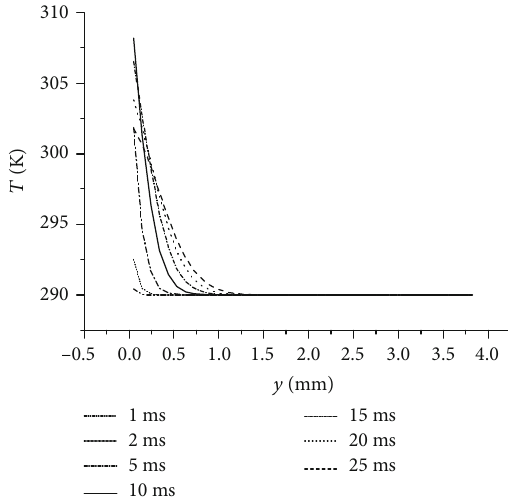
Figure 11: Temperature distribution in the grain.